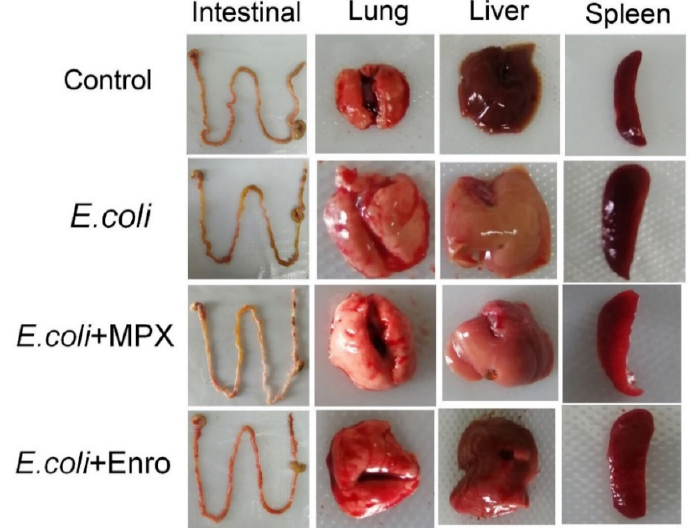
Fig. 2. Autopsy results of mouse intestines and organs after E. coli infection.